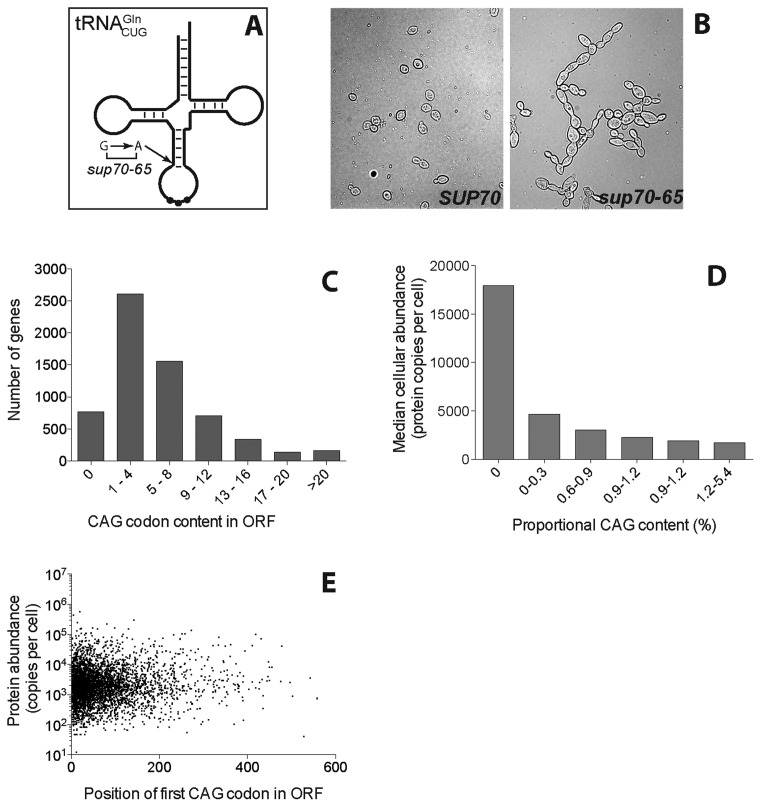
CAG codon usage in the transcriptome. (A) The CAG glutamine codon is recognised by the single copy SUP70 gene, encoding \documentclass[12pt]{minimal}
\usepackage{amsmath}
\usepackage{wasysym}
\usepackage{amsfonts}
\usepackage{amssymb}
\usepackage{amsbsy}
\usepackage{upgreek}
\usepackage{mathrsfs}
\setlength{\oddsidemargin}{-69pt}
\begin{document}
}{}${\rm{tRNA}}_{{\rm{CUG}}}^{{\rm{Gln}}}$\end{document}. The sup70-65 allele defines a variant lacking a base-pairing interaction at the base of the anticodon stem. (B) The sup70-65 mutation causes a pseudohyphal growth phenotype. (C) The CAG frequencies were recorded for all S. cerevisiae ORFs. (D) The cellular abundance of yeast proteins (66) was plotted against the binned proportional content of CAG codons relative to ORF length. (E) For each yeast ORF, the position of the first (5′-most) CAG codon was recorded and plotted against the cellular protein abundance.